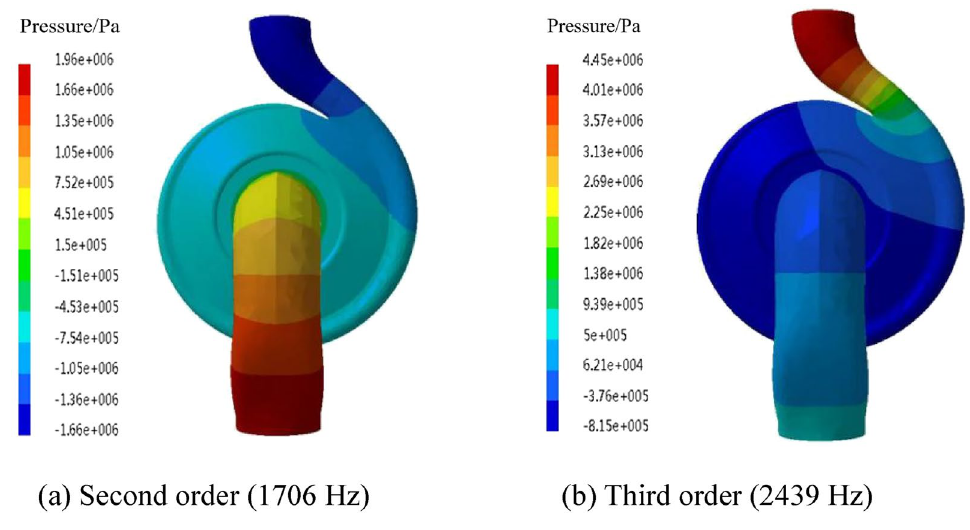
Figure 4. Internal acoustic